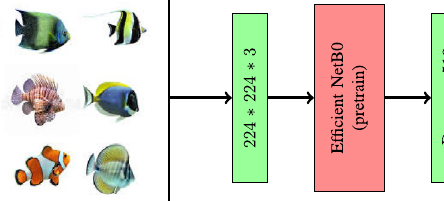
Fig. 3 Image classification module architecture: Under- water targets are fed into classification module as inpts and classified into classes in output